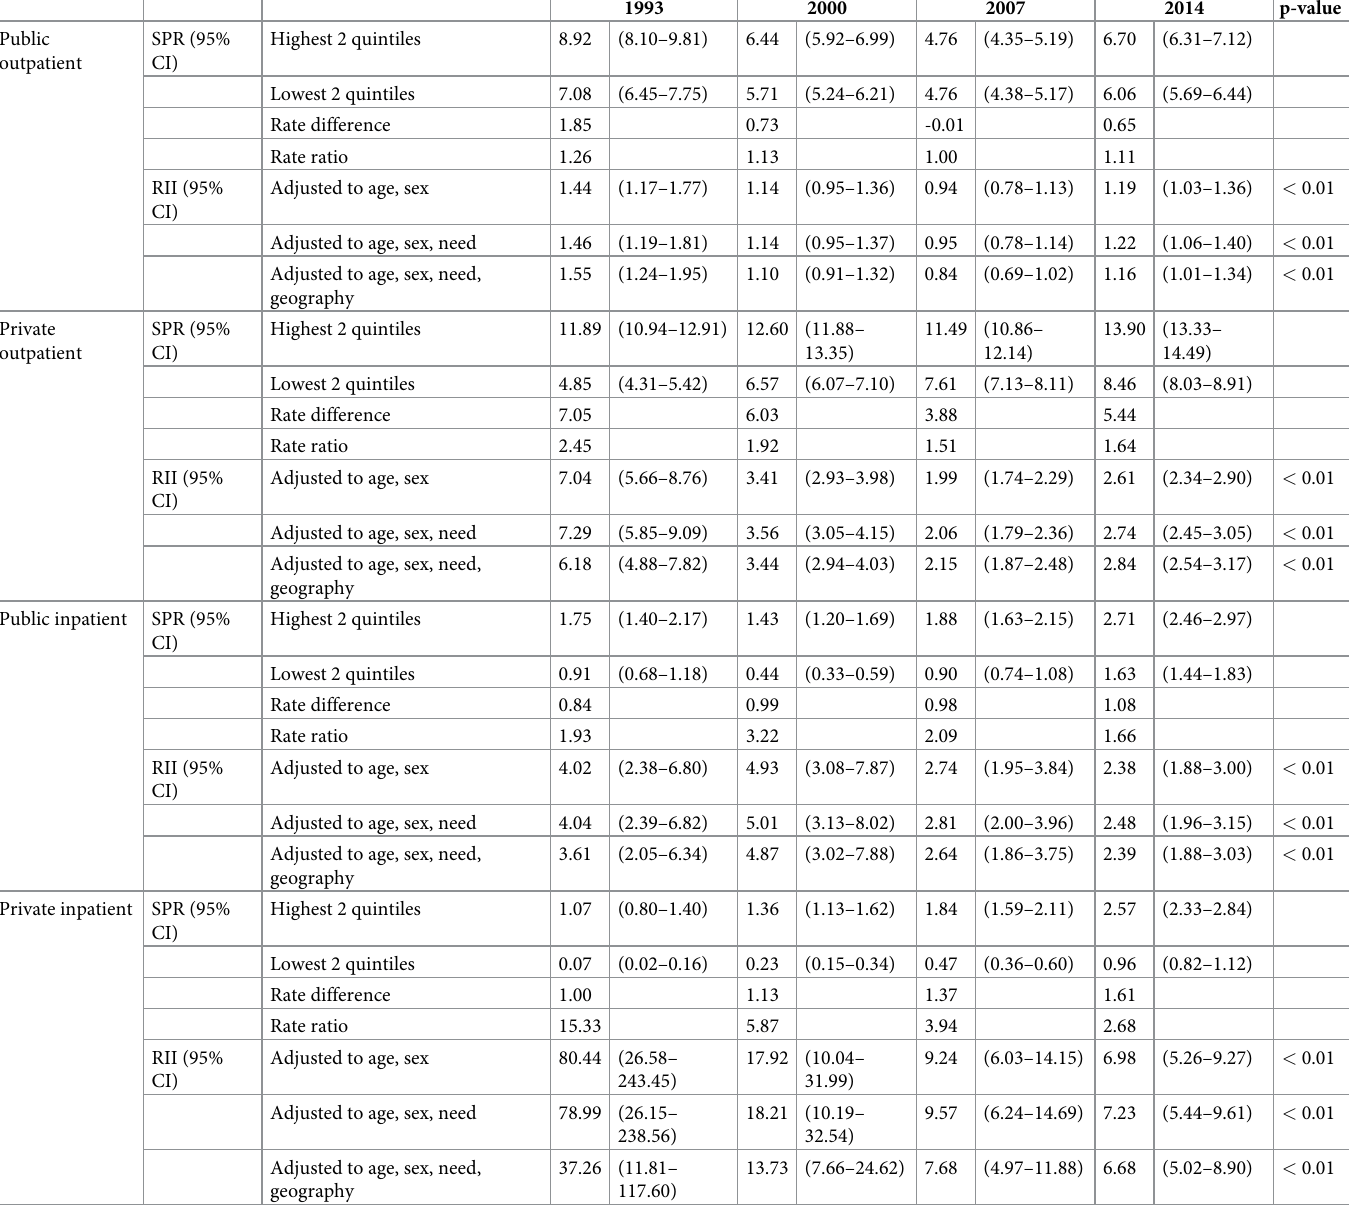
Table 3. Trends in absolute and relative income-related inequalities in healthcare utilisation,